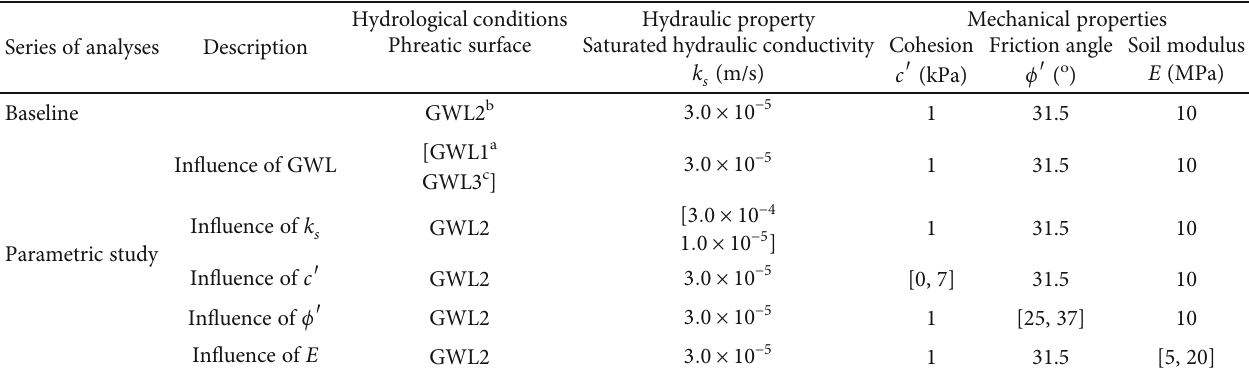
Table 3: Summary of the input property ranges of the parametric study.